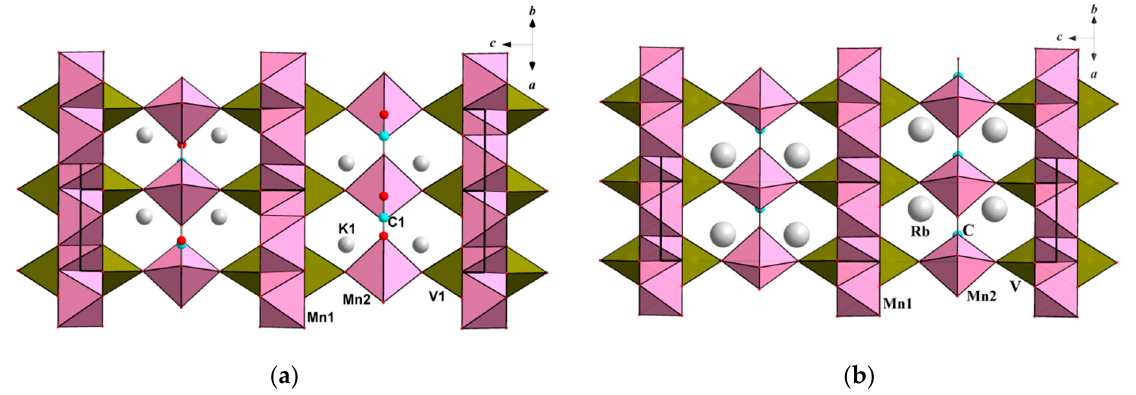
Figure 4. K 2 Mn 3 [VO 4 ] 2 (CO 3 ) ( a ) and Rb 2 Mn 3 [VO 4 ] 2 (CO 3 ) ( b ) crystal structures in the [110] projection, showing the different vertex orientation of vanadate tetrahedra.